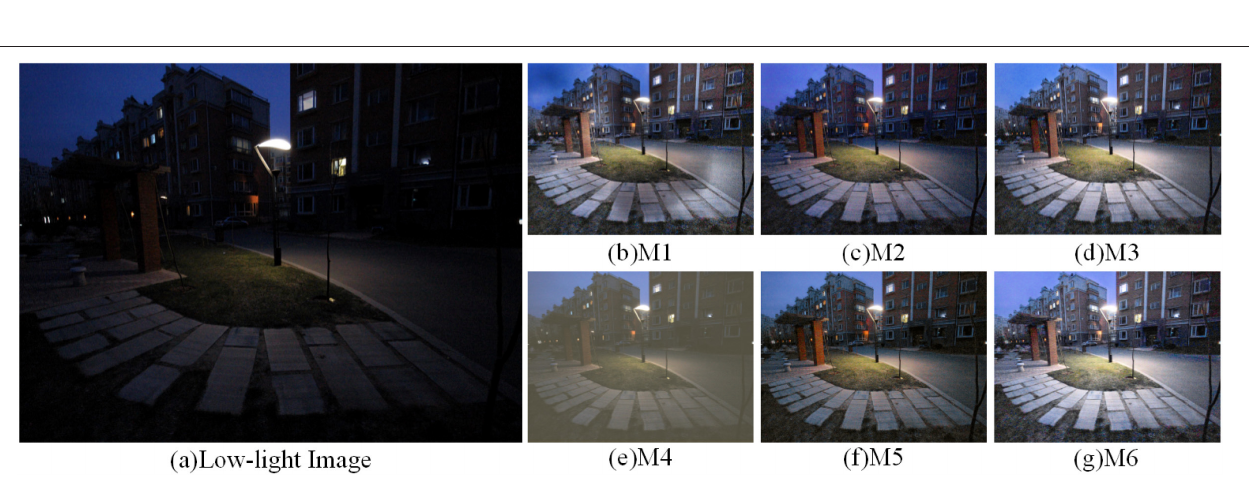
FIGURE 14 | Visual comparison results with different combinations of modules in the LIME dataset. (A) shows the low light image and (B–G) show the effect of the enhanced low light image with different combinations of modules.